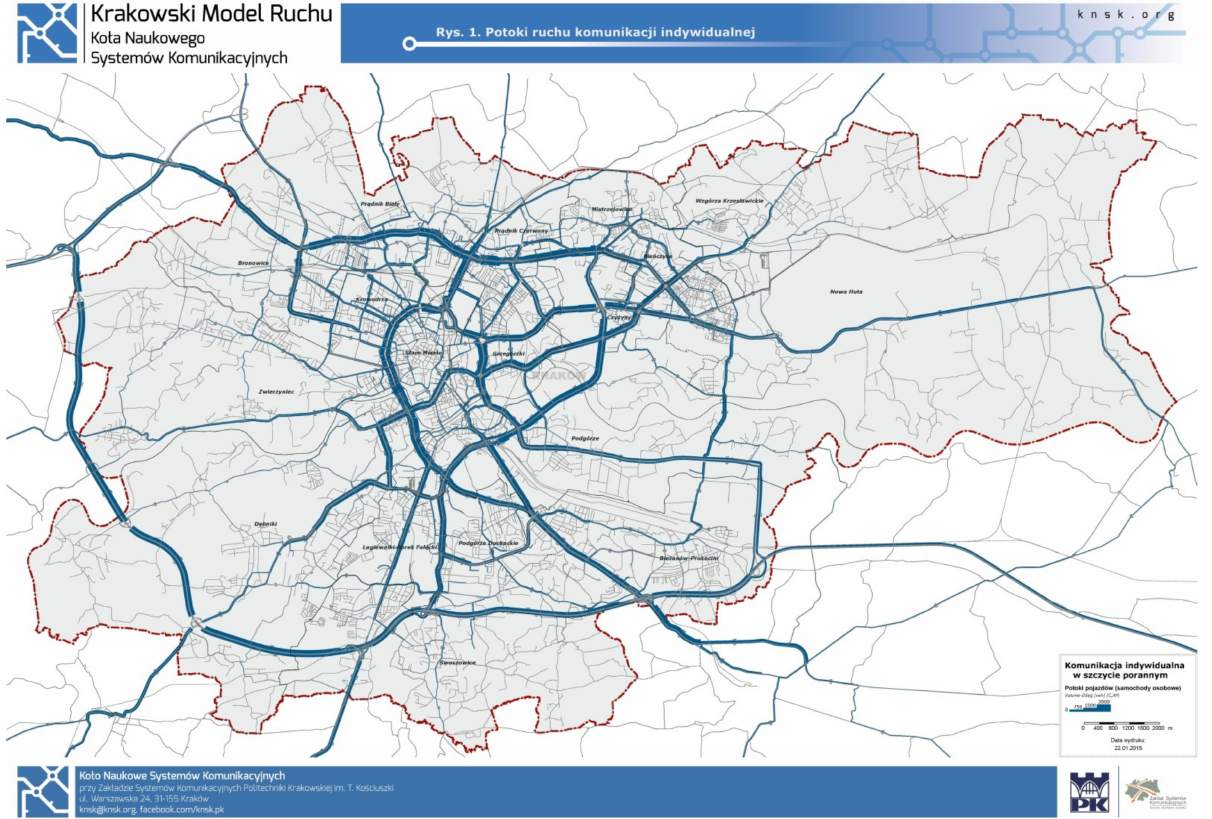
Figure 4. Example of traffic assignment for the city of Krak ó w. Source: